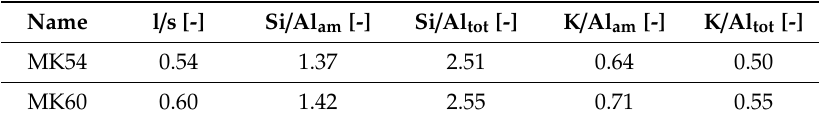
Table 1. Liquid / solid ratios (l / s), molar Si / Al ratios (Si / Al tot : total amount of Si and Al from metakaolin; Si / Al am : amorphous Si and Al of metakaolin) and molar K / Al ratios (K / Al tot : total amount of Al from metakaolin; K / Al am : amorphous Al of metakaolin) of MK54 and MK60. Chemical composition and amorphous amount of Si and Al for Si / Al ratios were taken from Vogt et al. [53]. Name l / s [-] Si / Al am [-] Si / Al tot [-] K / Al am [-] K / Al tot [-] MK54 0.54 1.37 2.51 0.64 0.50 MK60 0.60 1.42 2.55 0.71